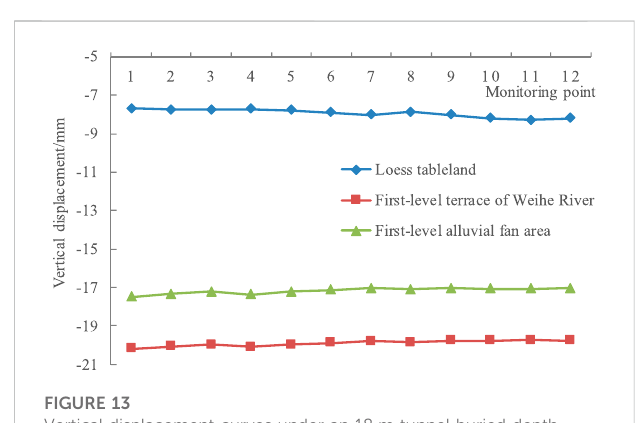
the tunnel depth is constant. Figure 12 and Figure 14 show that the vertical displacement curves of monitoring points in the existing pipe gallery under different tunnel buried depths.